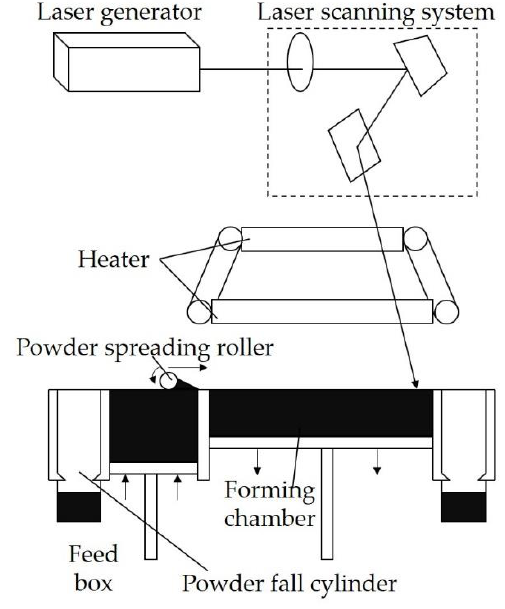
Table 1. Main parameters of the selective laser sintering (SLS) process.